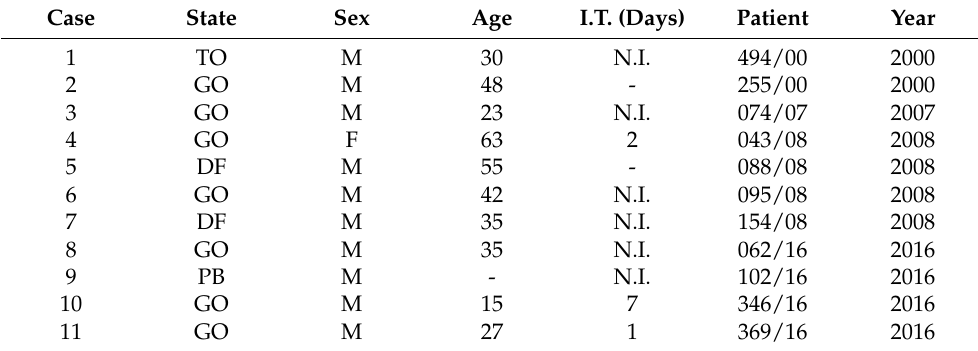
Table 1. Characterisation of yellow fever patients according to their precedence, age and gender, illness time